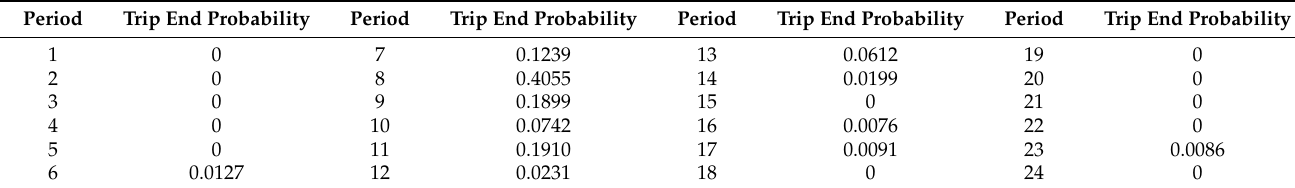
Table 1. Statistics of travel time from home to work (JA) on work days.